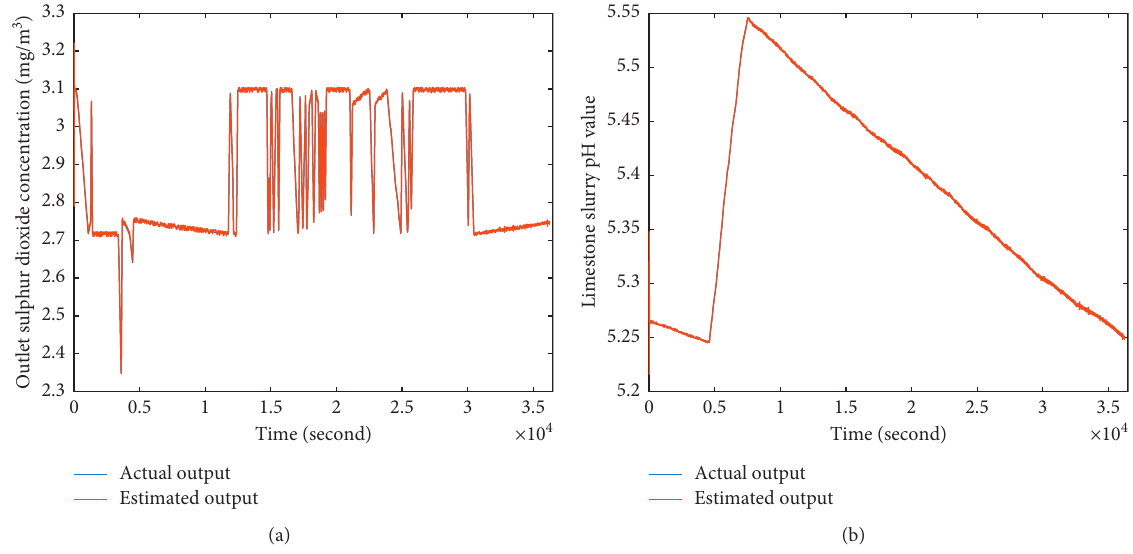
Figure 7: Identification results of dynamic neural network with two nodes in the hidden layer: (a) result for outlet sulphur dioxide concentration; (b) result for the pH value in